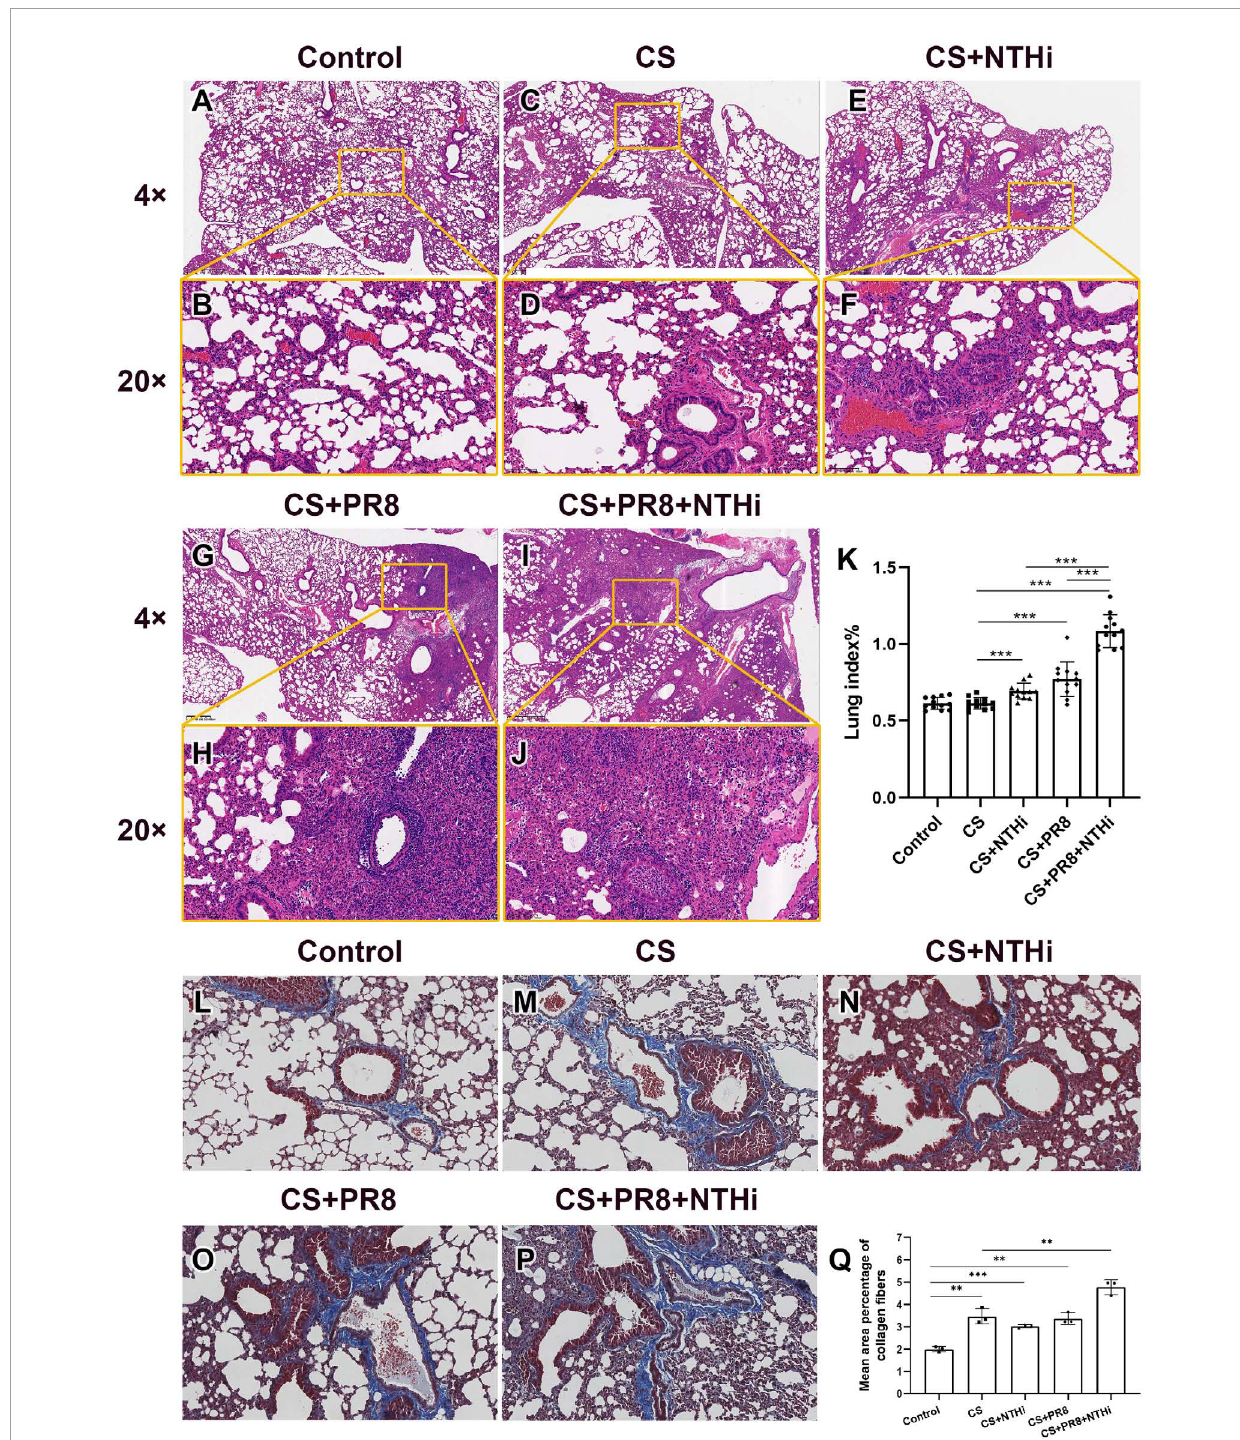
FIGURE6 Coinfection aggravates lung injury in AECOPD mice. Pathological changes of control group (A,B) , CS-exposed group (C,D) , CS + NTHi group (E,F) , CS + PR8 group (G,H) , and CS + PR8 + NTHi group (I,J) were observed in H and E-stained sections. Original magnification, × 4 and × 20. Lung index was calculated as lung weight/body weight × 100 (K) . Collagen fibers of control (L) , CS-exposed (M) , CS + NTHi (N) , CS + PR8 (O) , and CS + PR8 + NTHi (P) groups were stained with Masson’s trichrome and quantified using ImageJ (Q) . Data are representative images ( n = 3 in each group) or expressed as mean ± SD ( n = 12 for lung index, n = 3 for percentage of collagen fibers). ∗∗ p < 0.01 and ∗∗∗ p <